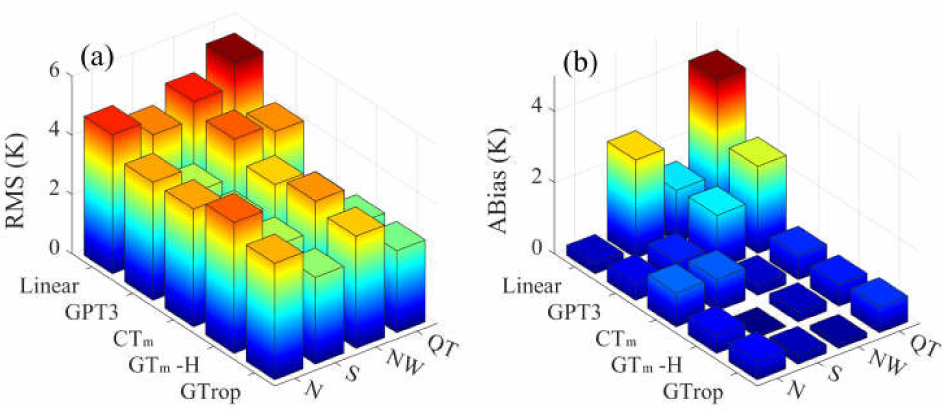
Figure 7. Average RMS and absolute Bias (ABias) of the five T m models in the four geographical regions of China over the period of 2011 to 2020. ( a ) refers average RMS of the five T m models in the four geographical regions of China over the period of 2011 to 2020 and ( b ) refers absolute Bias (ABias) of the five T m models in the four geographical regions of China over the period of 2011 to